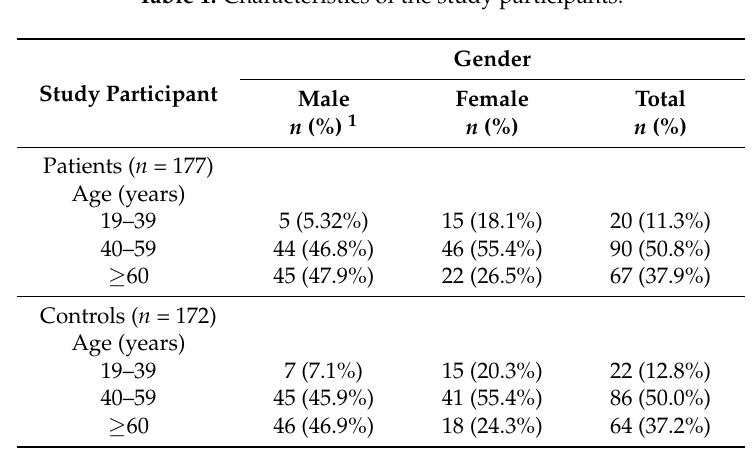
Table 1. Characteristics of the study